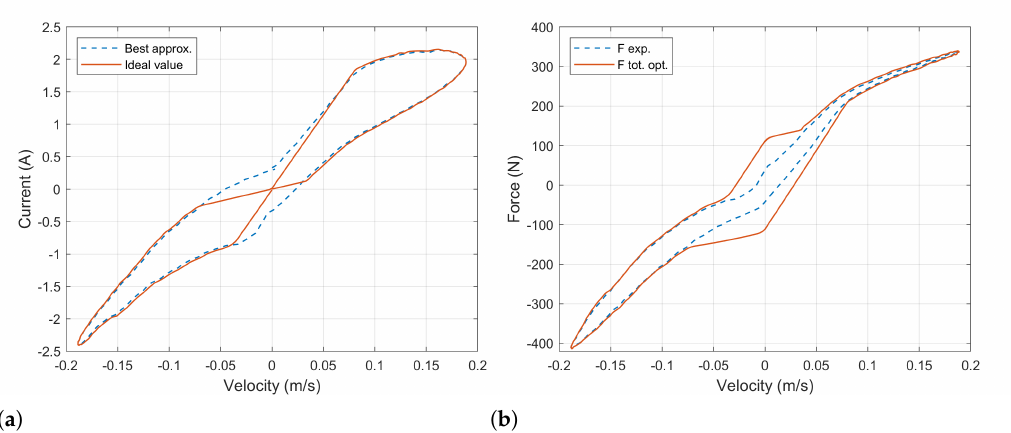
Figure 15. ( a ) DC–DC converter as dynamic load. Closing period as a function of the velocity. ( b ) DC–DC converter as dynamic load. Damping force produced by the BS-EHSA